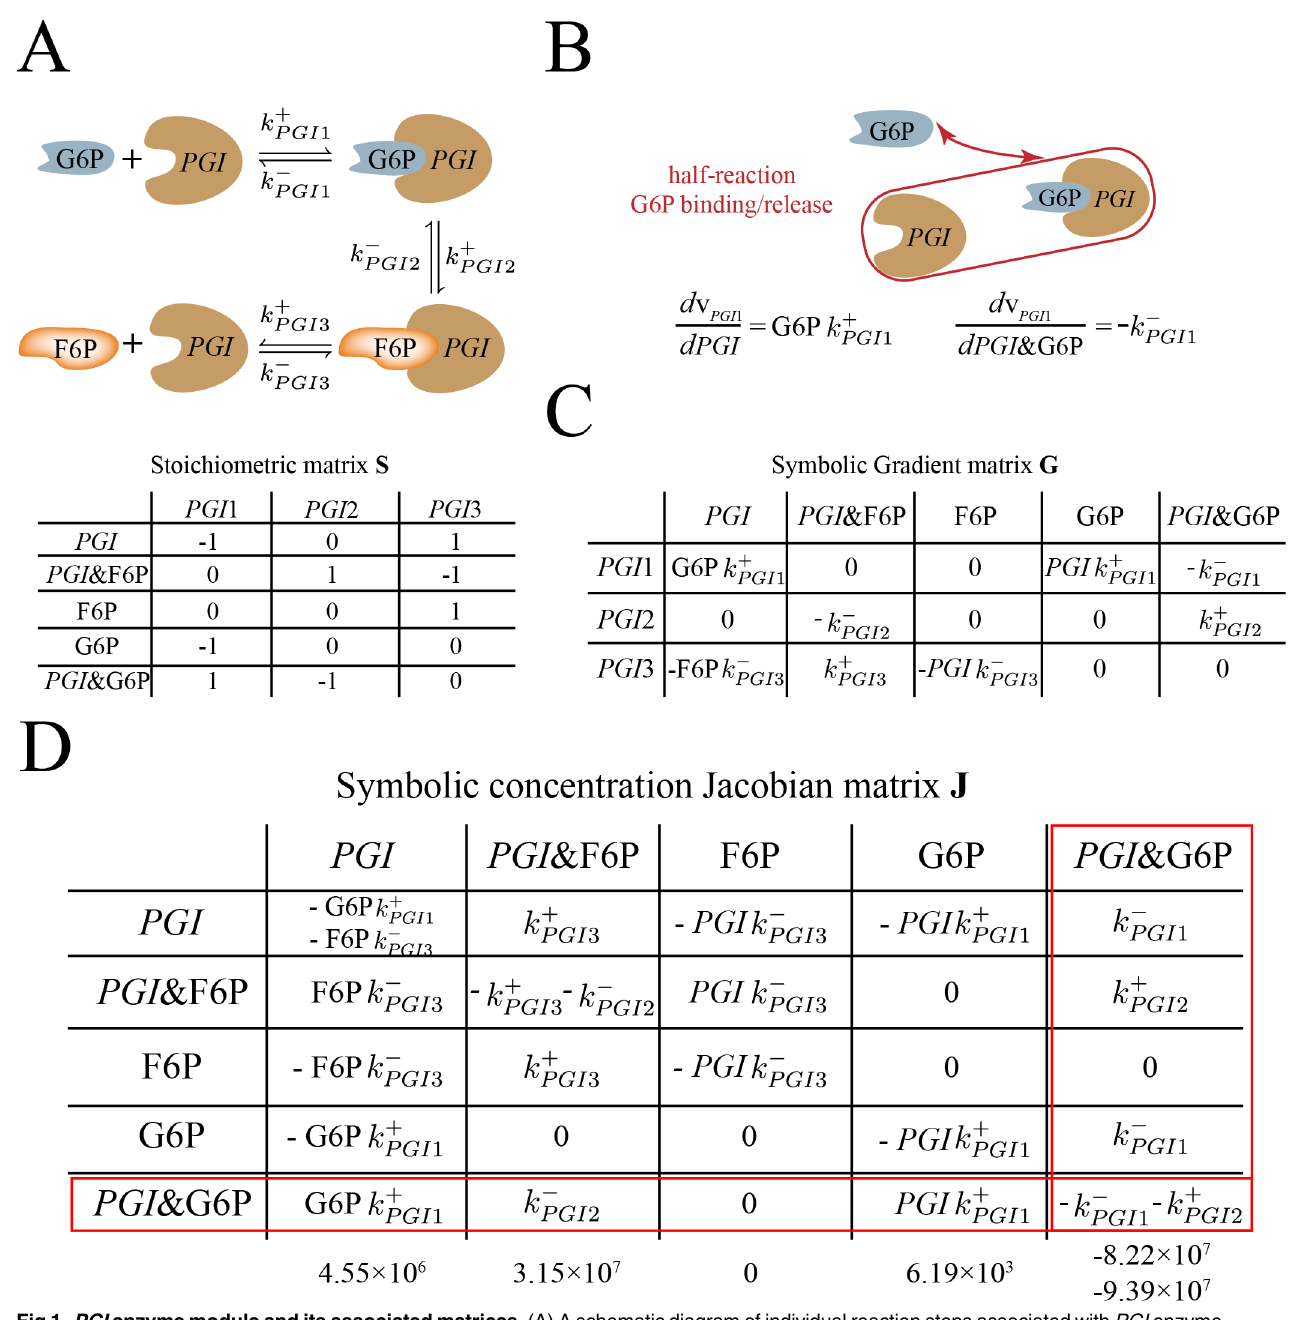
PLOS ONE | https://doi.org/10.1371/journal.pone.0189880 December21, 2017 4 /